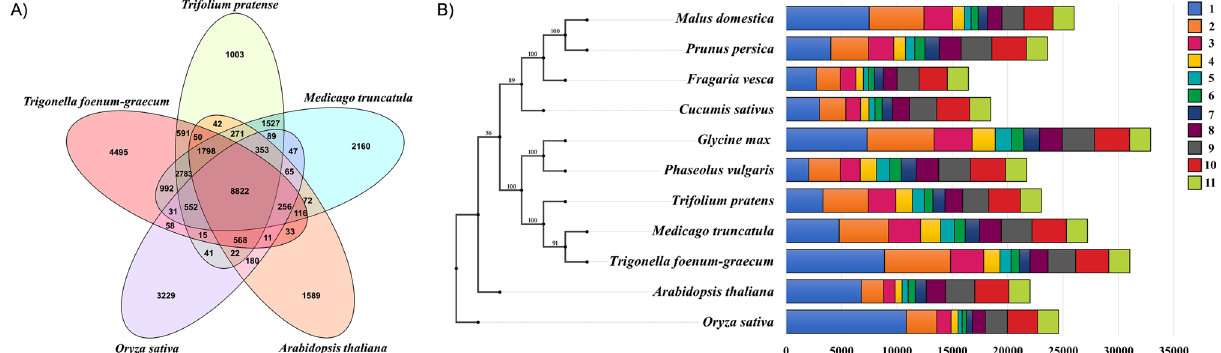
Figure 2. Orthology analyses ( A ) OrthoMCL: Venn diagram representing the common and unique orthogroups for the five proteomes studied. ( B ) Proteinortho results showing the distribution of orthogroups between few selected plants from the subclass Rosids (including Arabidopsis thaliana and few plants from Faboideae and Rosaceae) and Oryza sativa . Each coloured section represents the number of species with which the orthogroups are